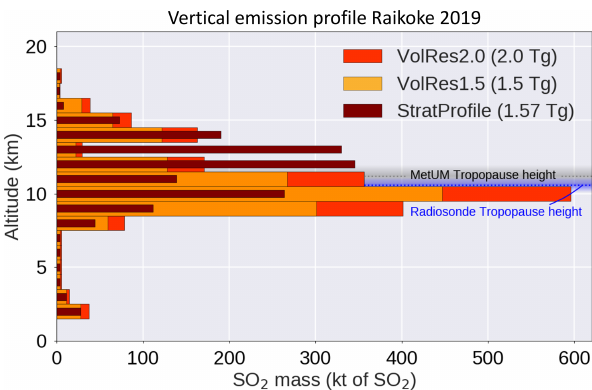
Figure 2. Estimated total emitted SO 2 mass for the Raikoke eruption between 21 June 2019 18:00UTC and 22 June 2019 03:00UTC. The initial emission profile was provided by the Vol- Res (Volcano Response) team, which is implemented in NAME for the 1.5Tg SO 2 simulation (VolRes1.5, orange). We also sim- ulated the same profile for a 2.0Tg SO 2 emission (VolRes2.0, red). Also included is a new emission profile estimate (StratPro- file, brown) based on the TROPOMI SO 2 VCD cloud on 23 June (see Sect. 2.3.4). This profile has a similar total mass emitted to VolRes1.5, but a larger fraction (69% instead of 43%) of its mass is emitted in the stratosphere (see Table 2). The grey line rep- resents the average tropopause height in the MetUM during the first 36h after the eruption at the location of the Raikoke volcano. The blue line and shading represents the average and the range of measured tropopause heights by the radiosondes released from the Petropavlovsk-Kamchatsky Airport (square in Fig. 1) during the first 36h after the